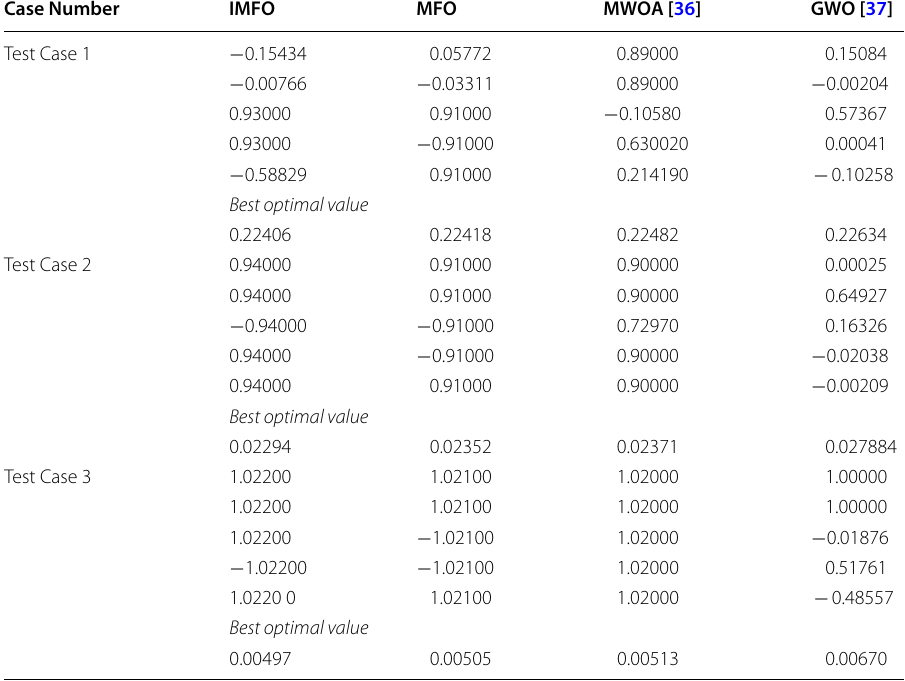
Table 1 Comparative analysis of three-phase transmission line parameters for capacitance/length ( µ F ) Case